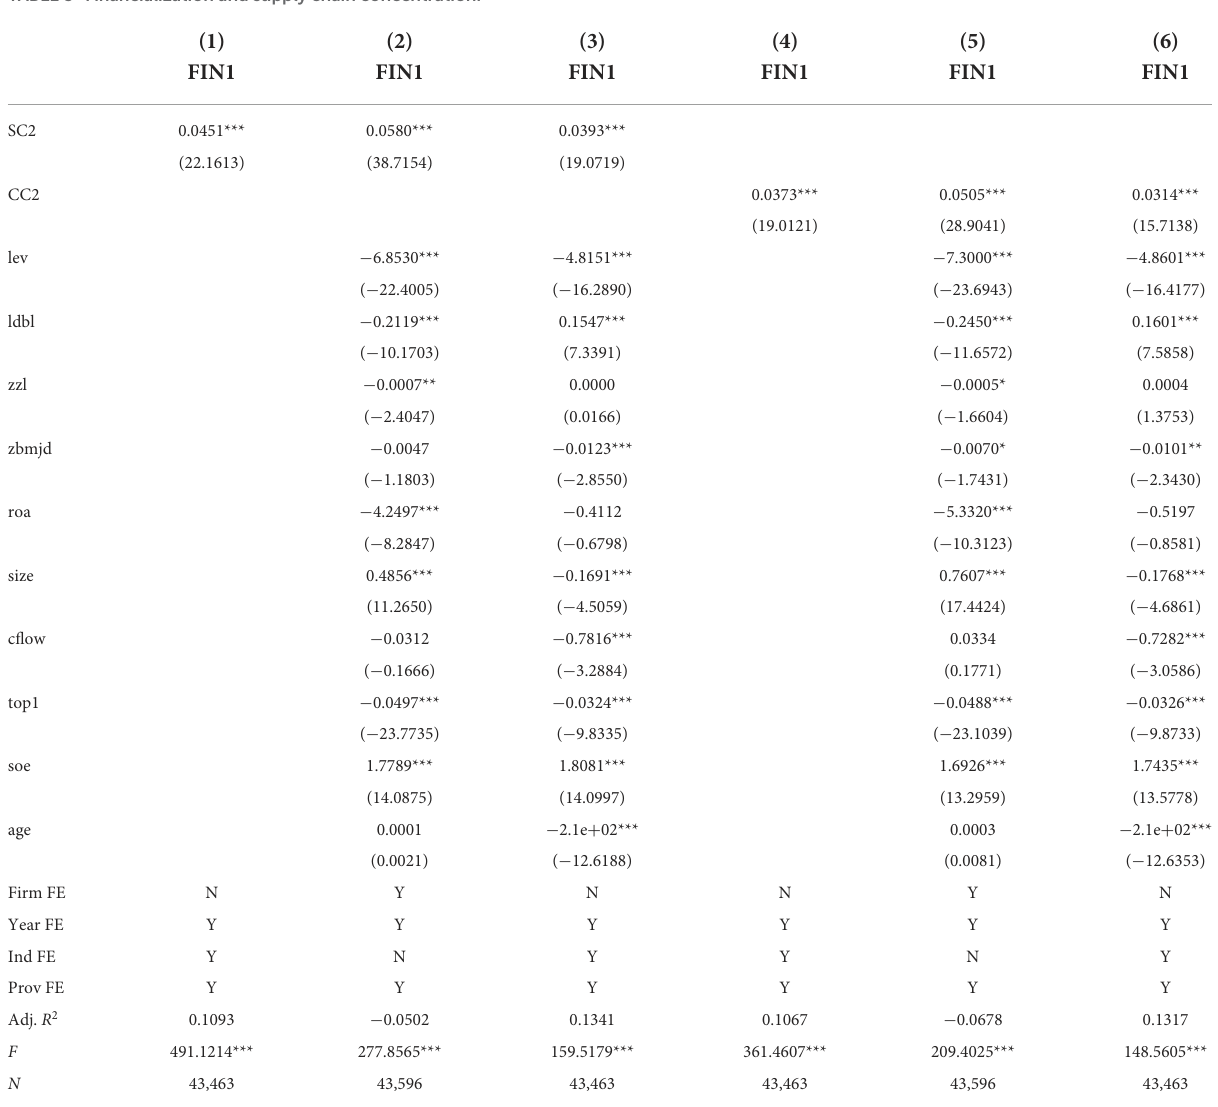
TABLE 3 Financialization and supply chain